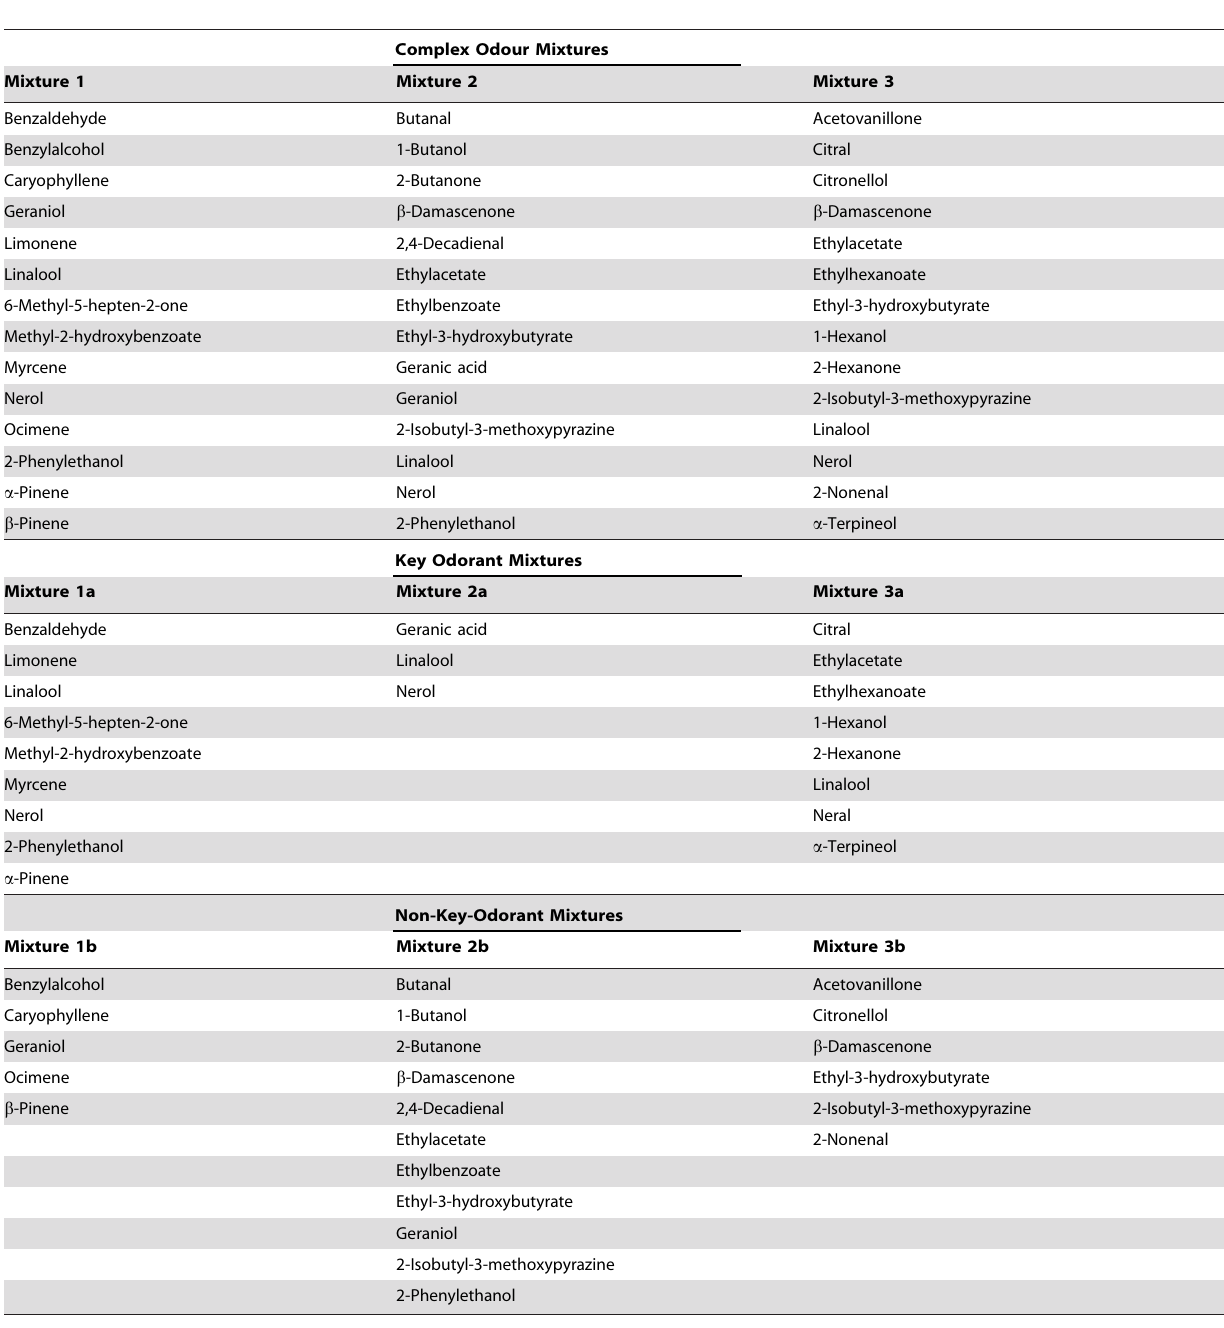
Table 2. Composition of Complex Odour Mixtures, Key Odorant Mixtures and Non-Key- Odorant